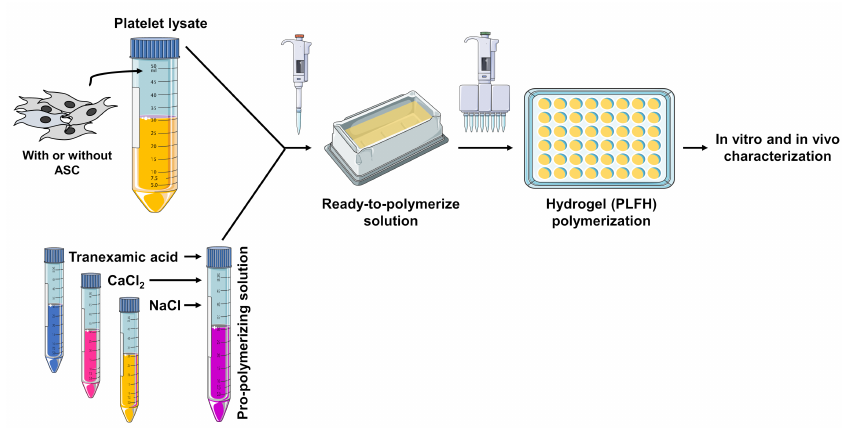
Figure 1. Schematic representation of PLFH